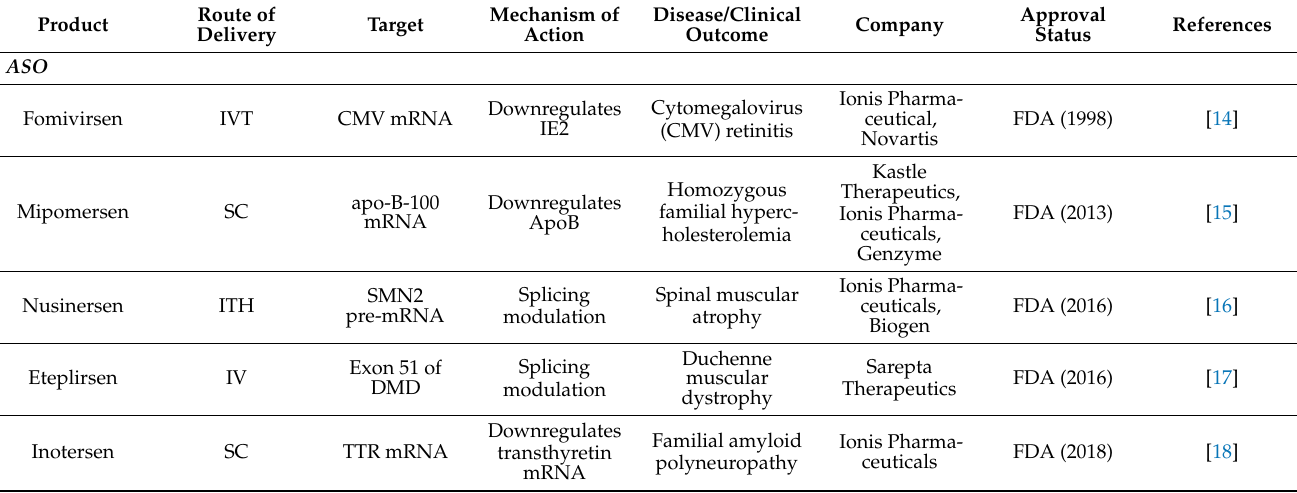
Table 1. FDA-approved RNA therapeutics in clinical